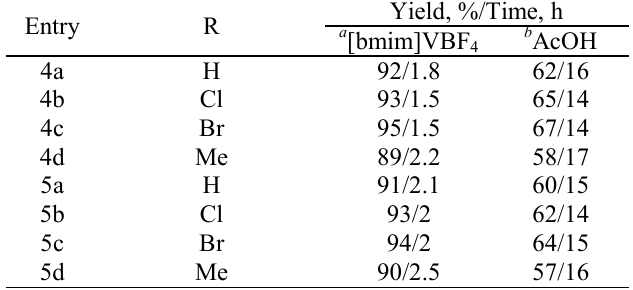
Table 1. Solvent and temperature optimization for the synthesis of 4(a-d) and 5(a-d). Yield, %/Time, h Entry R a [bmim]VBF b AcOH 4 4a H 92/1.8 62/16 4b Cl 93/1.5 65/14 4c Br 95/1.5 67/14 4d Me 89/2.2 58/17 5a H 91/2.1 60/15 93/2 62/14 94/2 Me 90/2.5